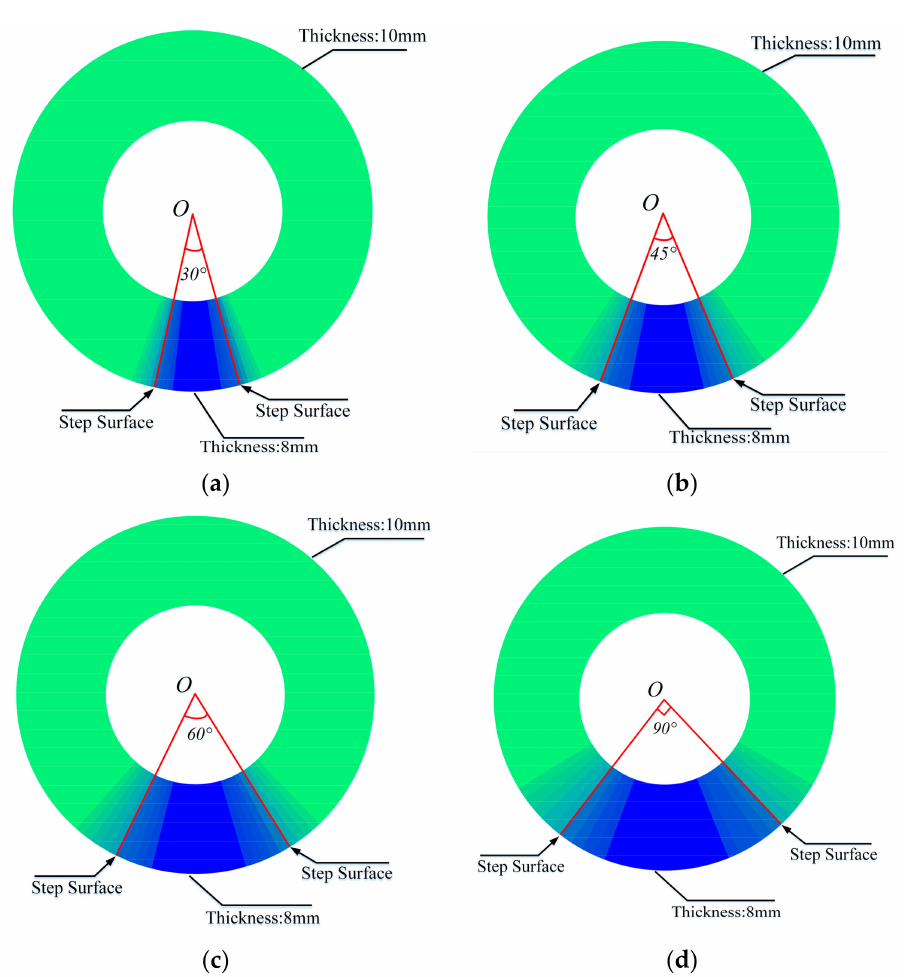
Figure 19. EDR amplitude quantification diagram of specimen 2. ( a ) Sector angle 30 ◦ . ( b ) Sector angle 45 ◦ . ( c ) Sector angle 60 ◦ . ( d ) Sector angle 90 ◦